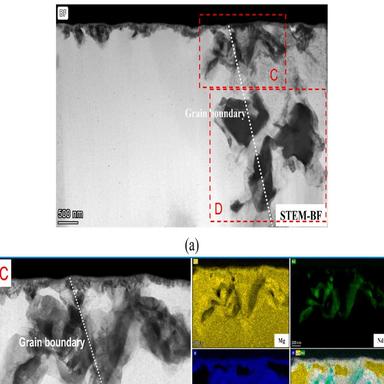
(a) STEM-BF image showing the cross-sectional morphology of grain boundary of ZM6 alloy after oxidation for 60 h; (b) enlarged STEM-BF image and corresponding EDS elemental distribution maps of Region C in (a); (c) enlarged STEM-BF image and corresponding EDS elemental distribution maps of Region D in (a); (d) EDS line-scan 4 showing the elemental distribution across a typical internal oxide precipitate in (c).